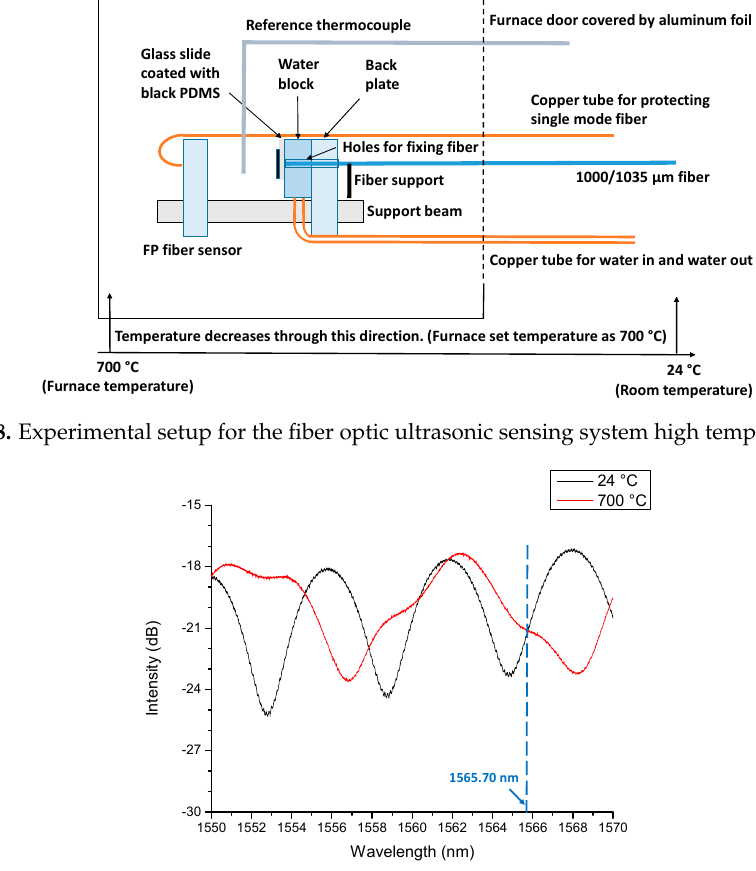
Figure 9. The spectra of the V20170321TEST1FP fiber sensor at different temperatures.